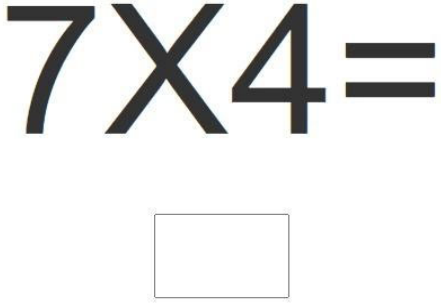
Figure 1. An example of a problem from the BGU ‐ MF.